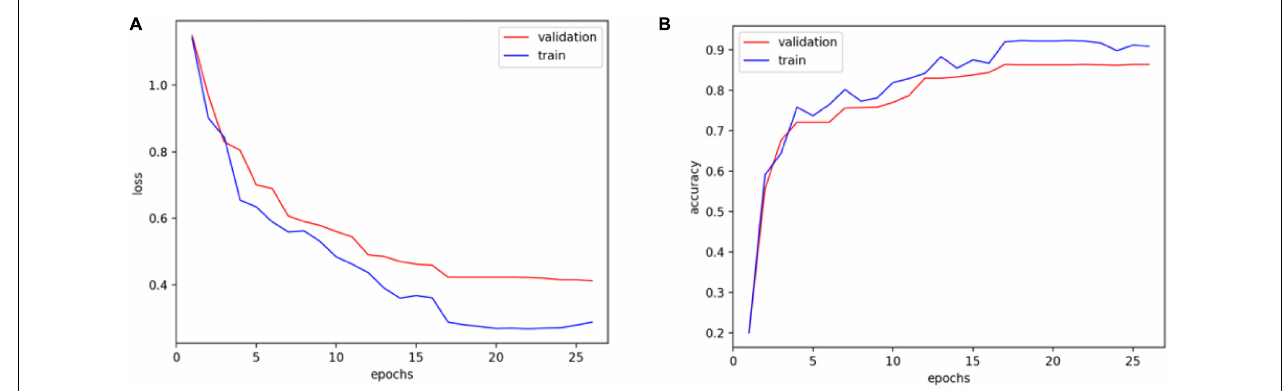
FIGURE 5 | Training and validation of (A) loss function and (B) accuracy over the epochs.